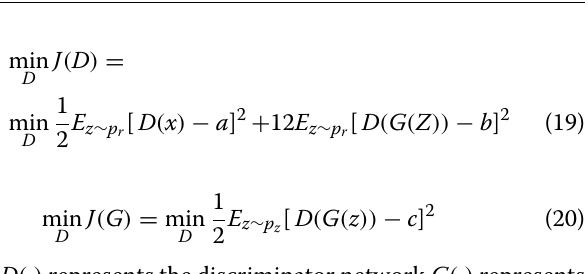
D ( · ) represents the discriminator network, G ( · ) represents the generator network. The input series data generate lantern space Z by Encoder network. The constants a (1) represent the real data label, and the constants b (0) rep- resents the generated data label. The constants c (1) is the value for the discriminator to judge the generated data is the real data.